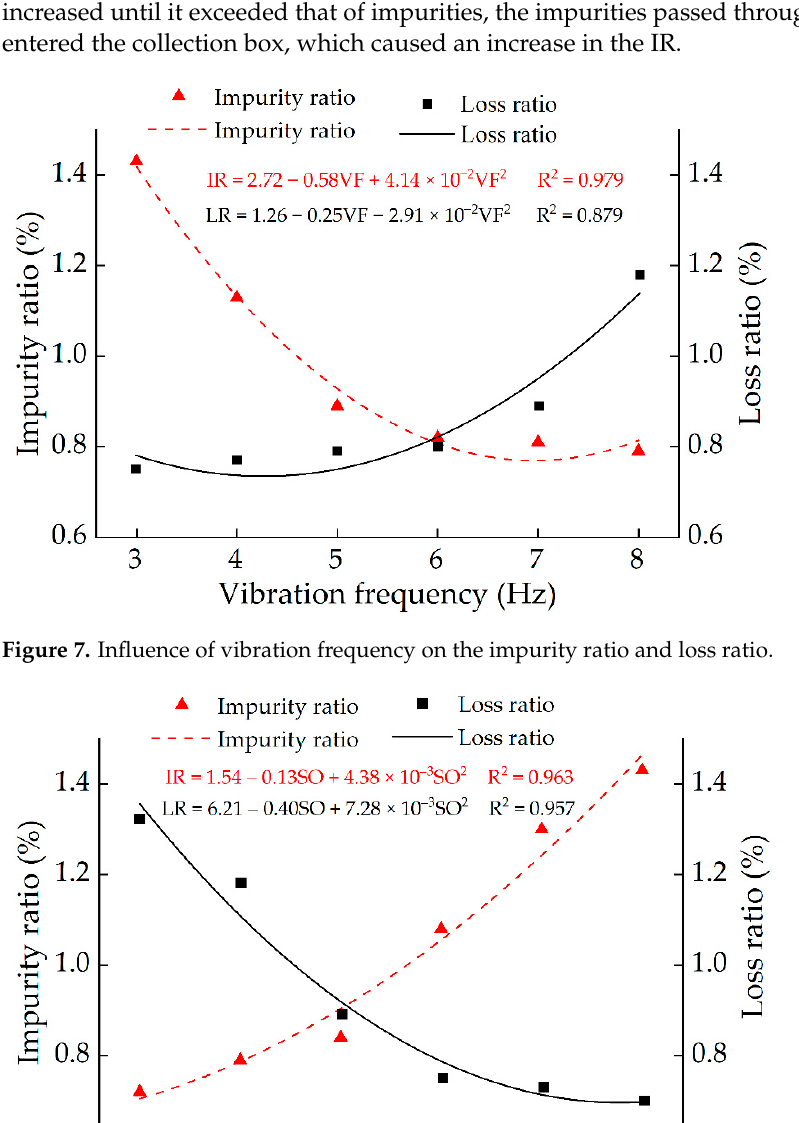
Figure 6. Influence of fan speed on the impurity ratio and loss ratio.